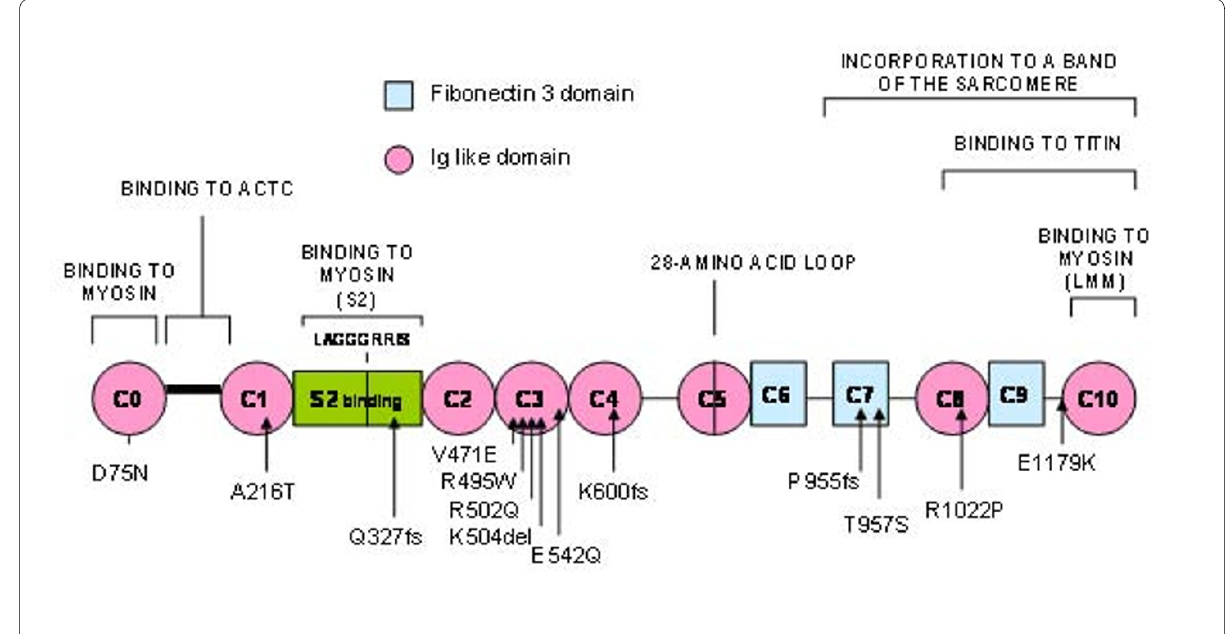
Figure 1 Myosin binding protein C secondary structure and localization of exonic mutations linked to HCM